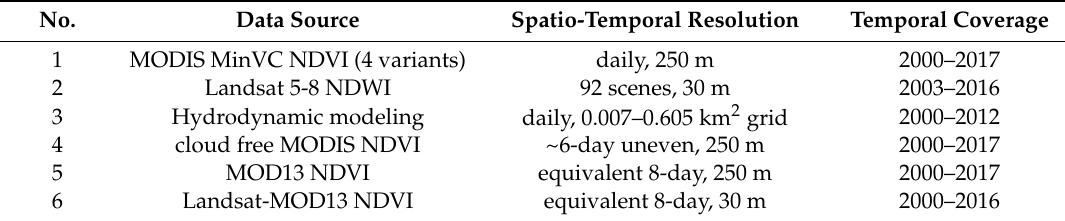
Table 2. List of water surface area